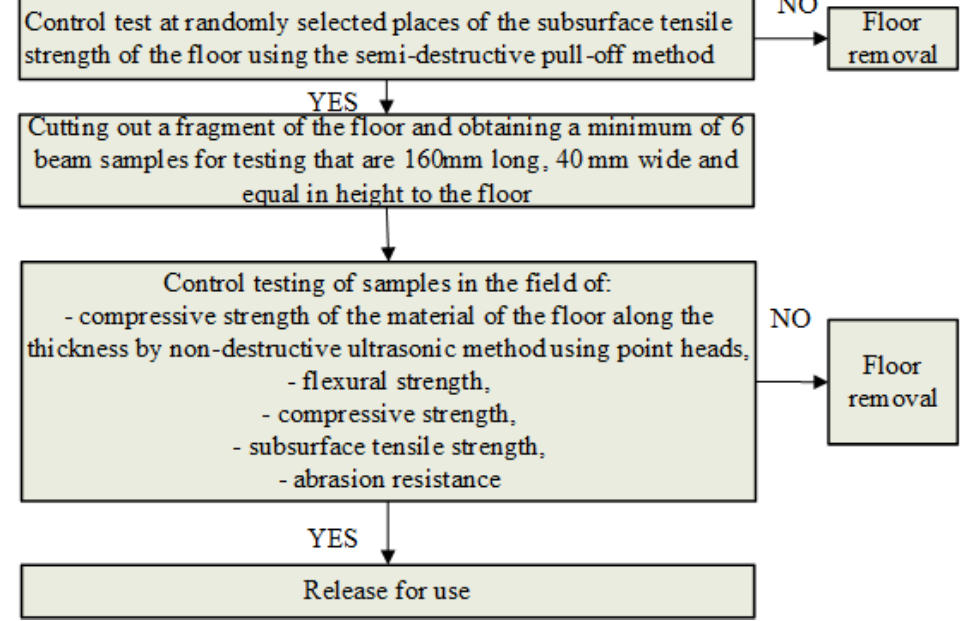
Figure 5. Methodology of controlling the technological process of executing floors made of Figure5. Methodologyofcontrollingthetechnologicalprocessofexecutingfloorsmadeofcement-based cement-based materials—Stage 3 (control strength tests after finishing the execution of the floor). materials—Stage 3 (control strength tests after finishing the execution of the